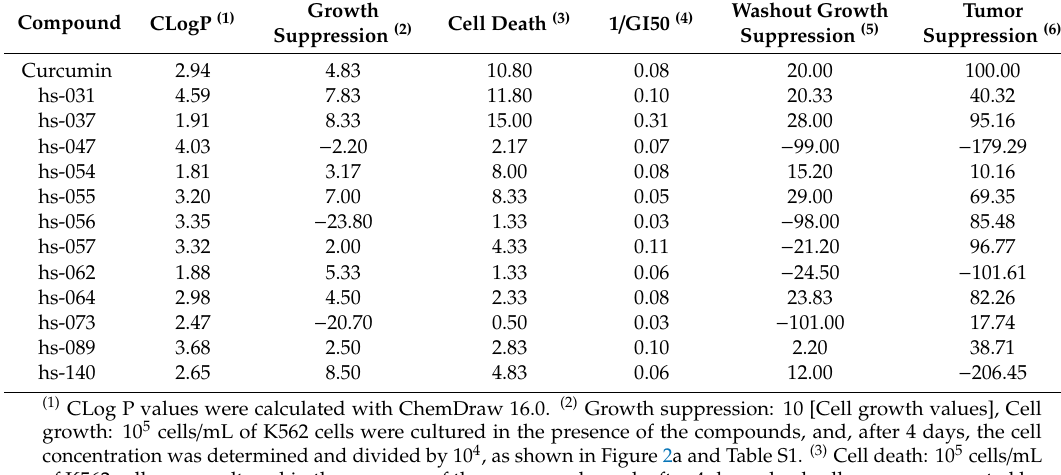
Table 1. Measurement variables of selected curcumin